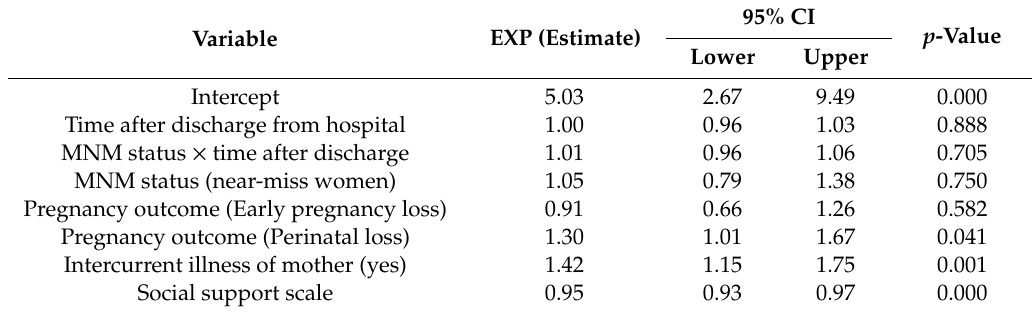
Table 3. Results of the negative binomial linear mixed-e ff ects model for depressive symptoms a,b .